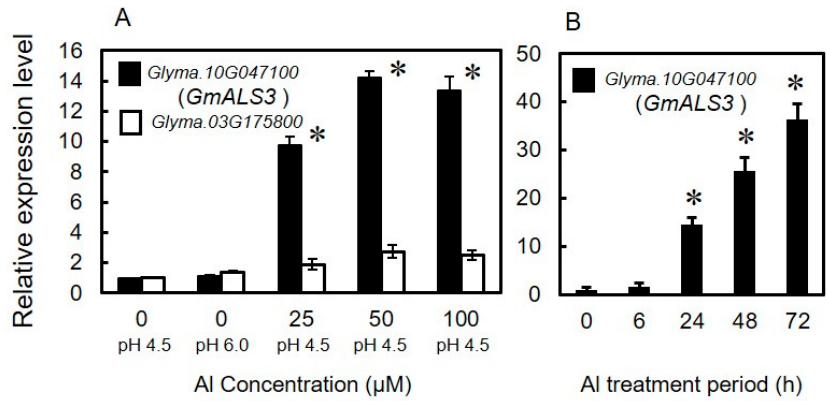
Figure 1. Expression of AtALS3 orthologs in soybeans. Plants were pregrown for 10 and then transferred to –Al (0 µ M AlCl 3 , pH 4.5 and 6.0) or Al-rhizotoxic (AlCl 3 , 25, 50 or 100- µ M (pH 4.5)) solutions. ( A ) Expression levels of Glyma.10G047100 ( GmALS3 ) and Glyma.03G175800 in the shoots were quantified after 24 h exposure of the roots to the Al-rhizotoxic or –Al (pH 4.5 and 6.0) solutions, asterisks indicate significant di ff erences compare to –Al at pH 4.5 (Student’s t -test, p < 0.05); ( B ) expression level of Glyma.10G047100 ( GmALS3 ) in the shoots of soybeans after exposure of the roots to Al-rhizotoxic solutions containing 50 µ M of AlCl 3 (pH 4.5) at various time points, asterisks indicate significant di ff erences compare to 0 h (Student’s t -test, p < 0.05). Expression level quantified using qRT-PCR using GmUBQ10 as an internal standard. Values are mean ± SE ( n =